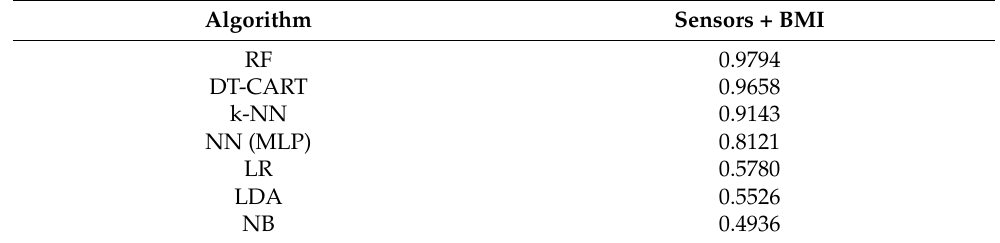
Figure 8. Average pressure distribution heat maps of the six common chair-bound stretches: ( a ) Right Arm Cross (RAC); ( b ) Left Arm Cross (LAC); ( c ) Both Arms Up (BAU); ( d ); Right Leg Up (RLU); ( e ) Left Leg Up (LLU); ( f ) Hanging Arms Down (HAD). Table 6. Classification performance of the tested algorithms in the stretch pose recognition